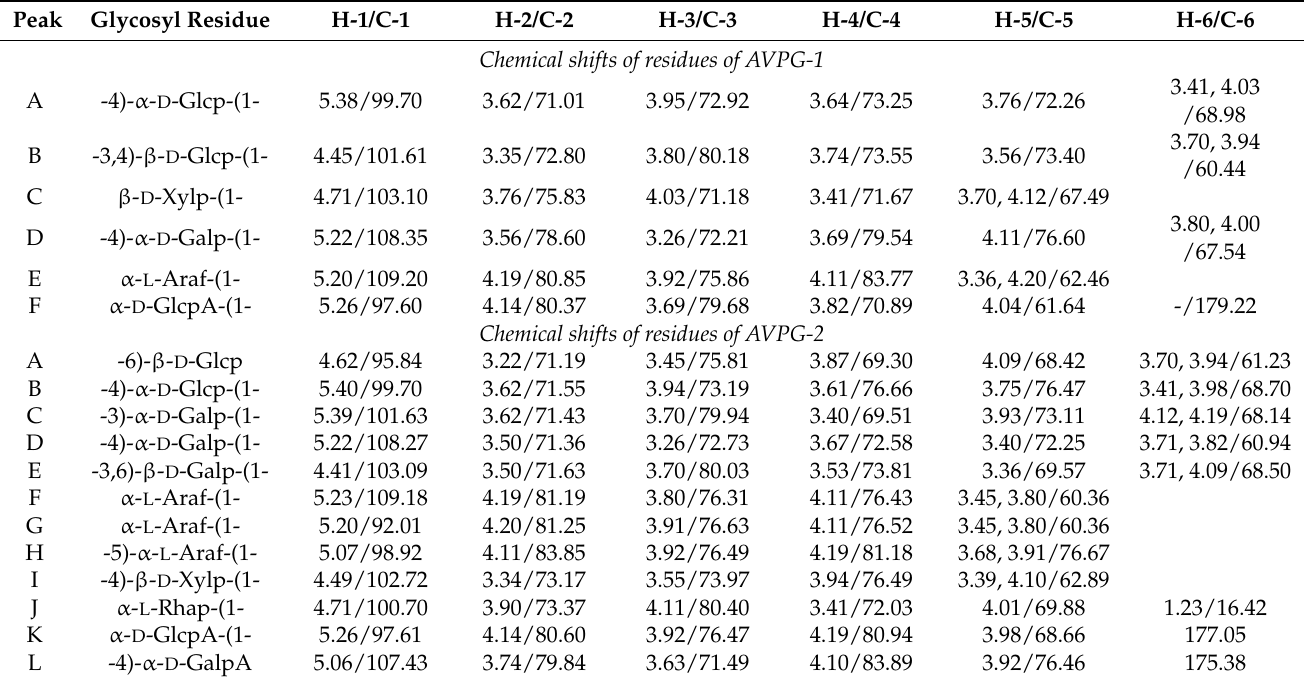
Table 2. 1 H and 13 C NMR chemical shifts (in ppm) for AVPG-1 and AVPG-2 recorded in D 2 O at 30 ◦ C.